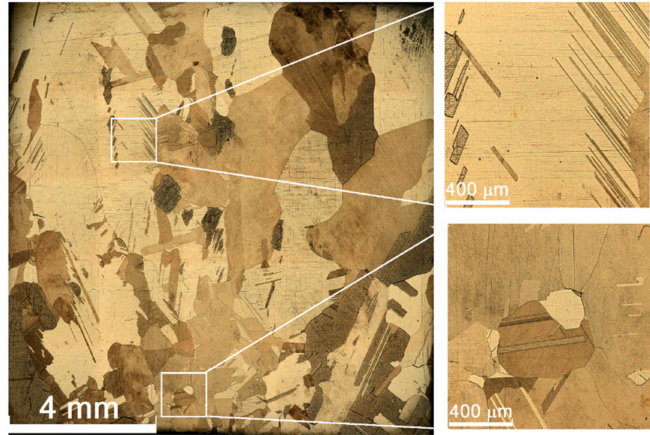
Figure 4. The microstructure of as-annealed Cu-7.5wt.%Al